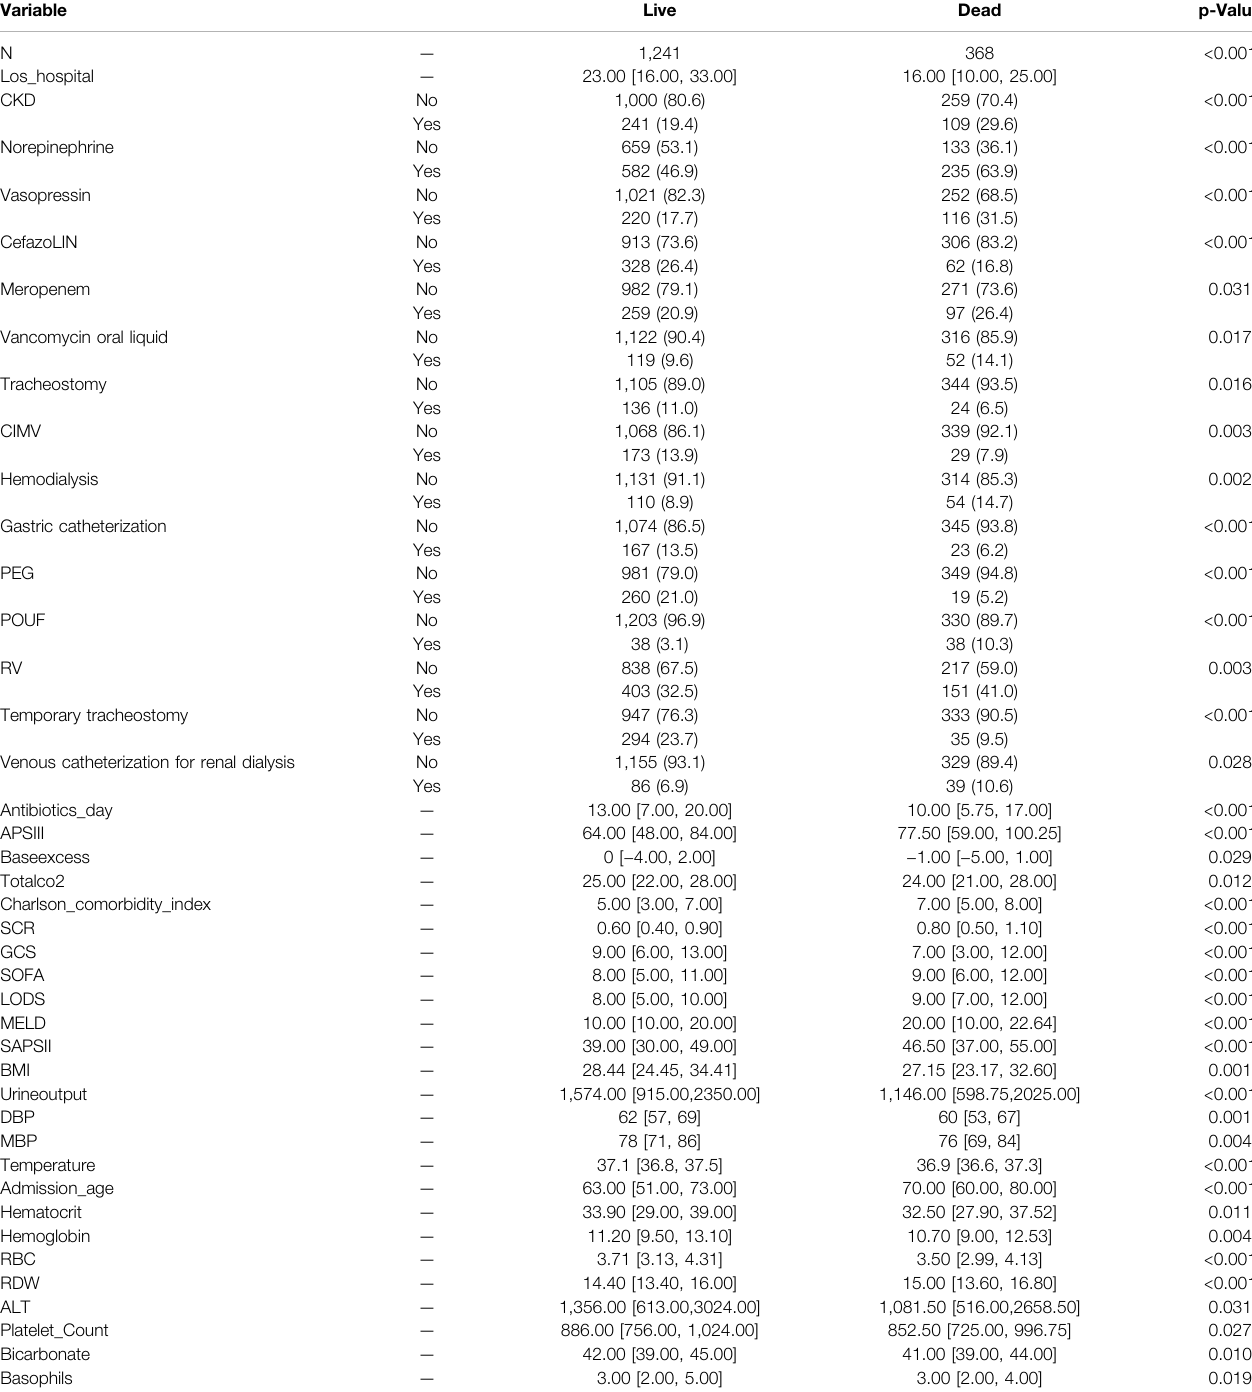
TABLE 1 | Baseline characteristics of patients in the